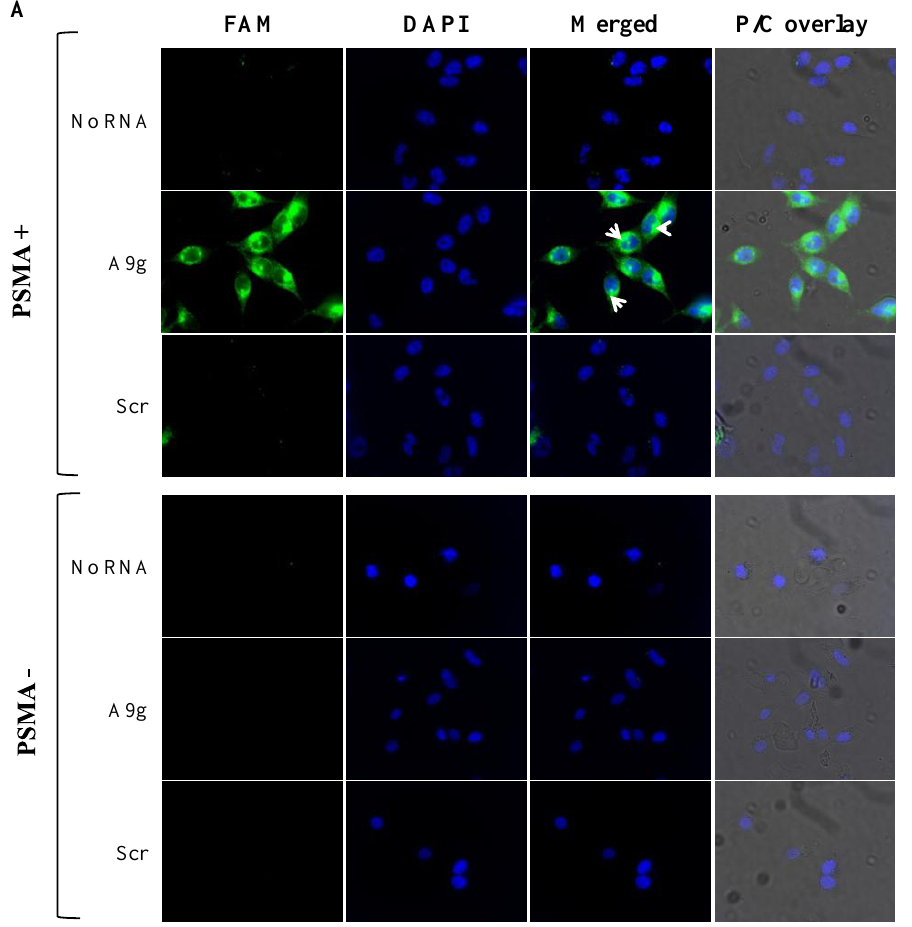
Figure 2. Fluorescence microscopy. ( A ) Direct fluorescence method. FAM labeled anti-PSMA RNA aptamer (A9g) was incubated with either PC3(PSMA+) or PC3(PSMA-) cells. A high salt wash step was performed to remove unbound or surface bound RNA. Internalized RNA was visualized using fluorescence microscopy. A scrambled, non- internalizing aptamer (Scr) was used as a negative control in these experiments. Florescence images were overlaid with DAPI and P/C (phase contrast) channels. Arrows indicate perinuclear localization of internalized A9g aptamer. ( B ) Antibody amplification method. FAM-labeled anti-TrkB RNA aptamer (C4-3) was incubated with either TrkB expressing or non-expressing HEK293 cells at 37 °C. FAM-labeled control aptamer (Scr) was used as a control for specificity. Unbound and surface bound RNA was removed as described above. Internalized RNA signal was amplified by incubation with an anti-FITC antibody and Alexa488 secondary antibody. Vehicle treated cells (No RNA) or cells subjected to incubation with antibodies alone (Ab control) were used as